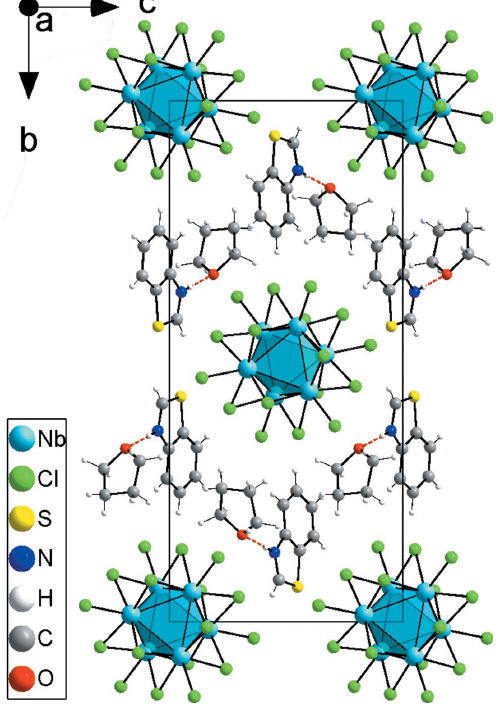
Figure 2 Packing of the cluster anions, cations and THF molecules in the unit cell of (HBTh) 2 [Nb 6 Cl 18 ] (cid:2) 2THF in a view along the a axis. The niobium cluster core is shown in a polyhedral representation. Hydrogen bonds are shown as red dashed lines. Table 2 Experimental